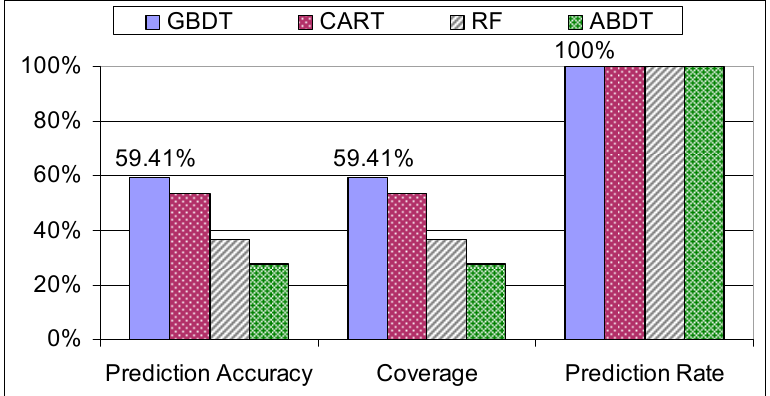
Figure 11. Evaluation of decision trees on the “Trainees” dataset.